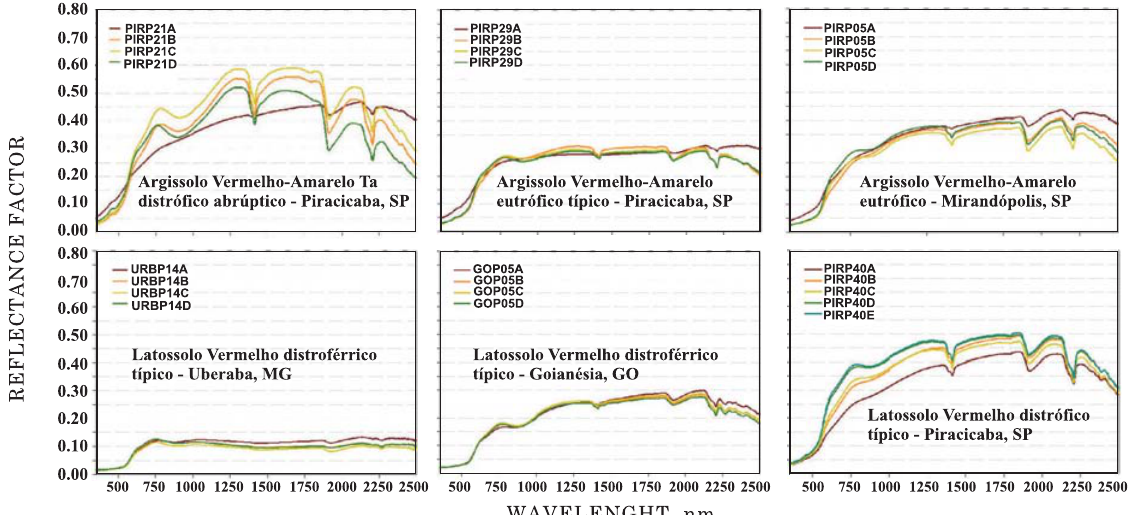
Figure 2. Spectral Curves from Soil Profiles: Argissolos and Latossolos, representing the Soil Spectral